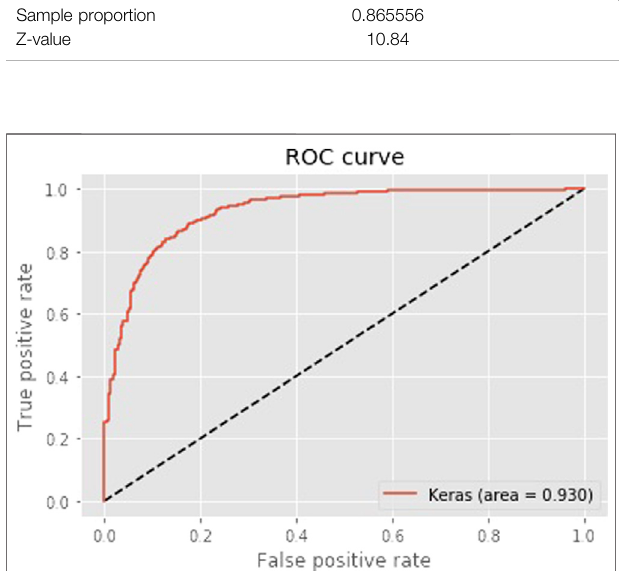
FIGURE9| ROCcurveforRNNmodelforclassifyingOCRsthatmention product defects from OCRs that do not mention product defects.